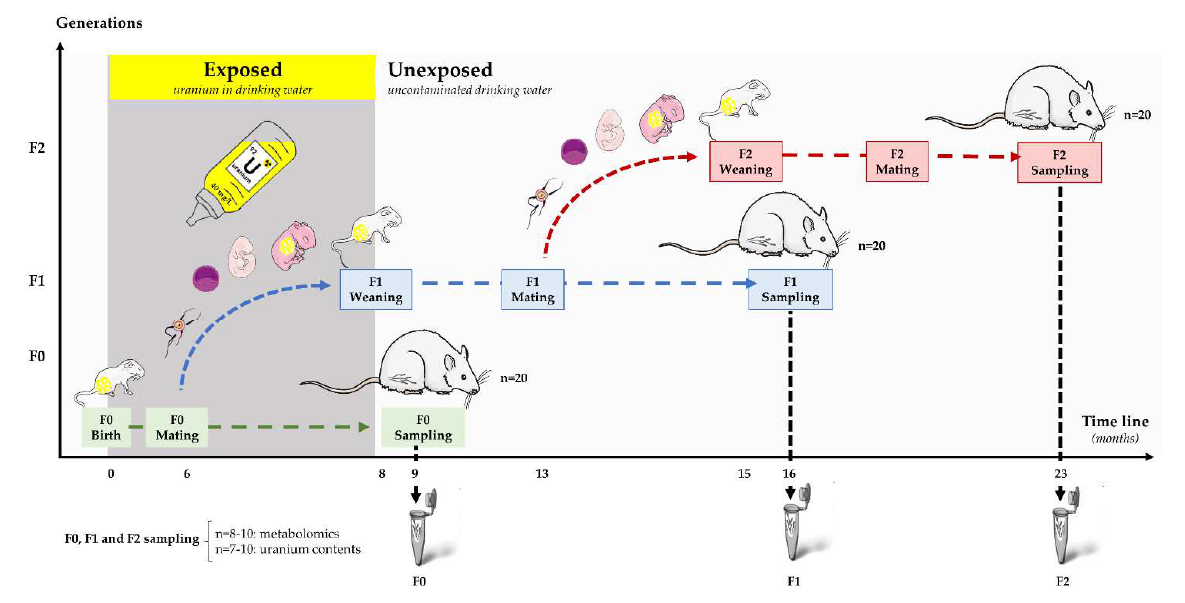
Figure 6. Multigenerational uranium exposure protocol. Three generations of male and female rats (F0, F1 and F2) (n = 20) were monitored. Generation F0 was exposed over 9 months from birth through drinking water with natural uranium (NU). Control animals drank uncontaminated mineral water. Generation F1 was contaminated in utero and through their mothers’ milk (F0) until weaning. After generation F1 was weaned, contamination was stopped, and all groups of rats were provided with uncontaminated mineral drinking water ad libitum. Generation F2 was only exposed to uranium from parental (F1) germ cells.